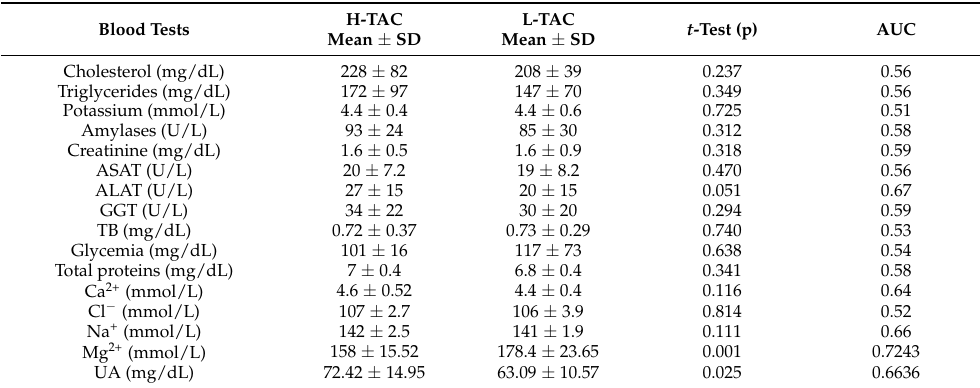
Table 1. Student’s t -test and area under the curve for standard follow-up biochemical blood tests were used to discriminate between patients with low and high tacrolinemia.